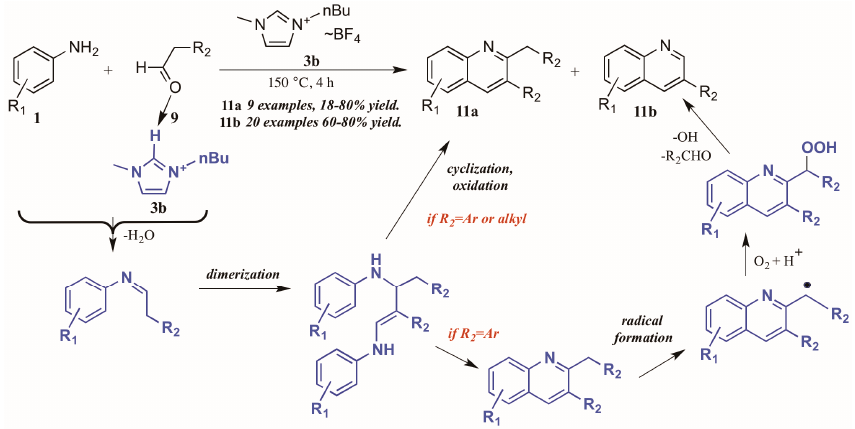
Figure 8. Divergent reactivity in the Doebner reaction in ionic liquid medium.